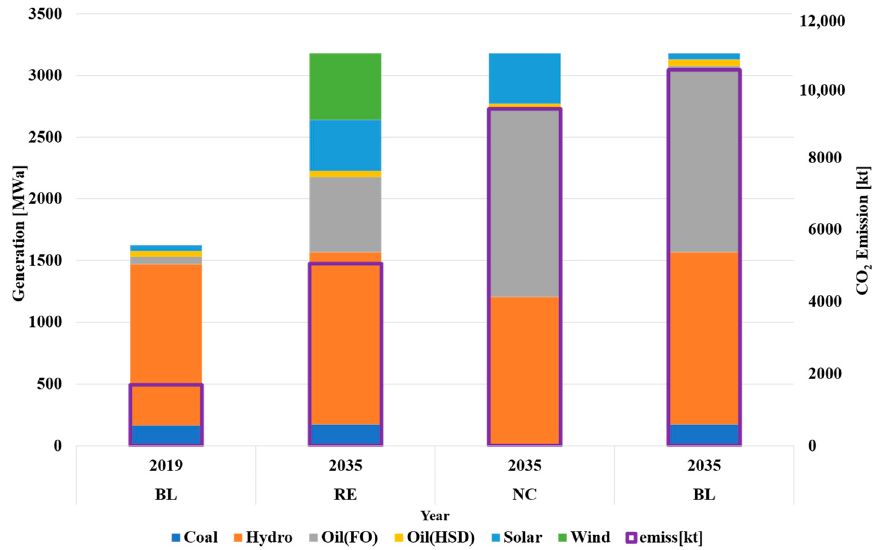
Figure 15. Comparison between the renewable, no coal scenario, and baseline scenarios.